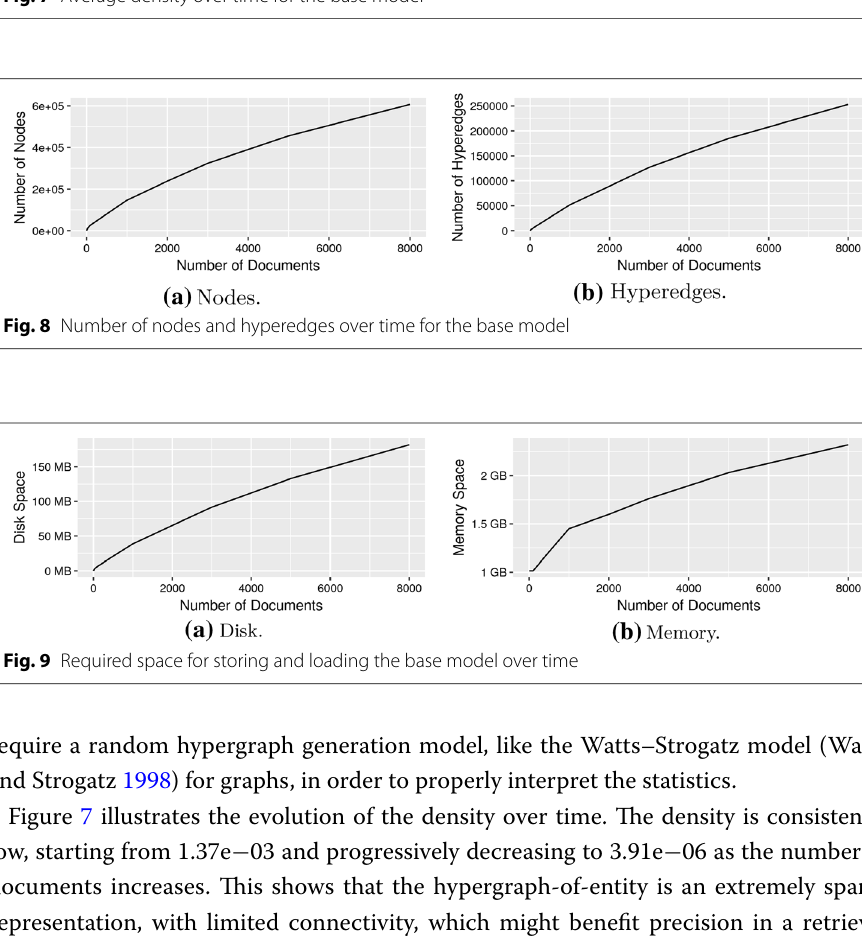
Fig. 7 Average density over time for the base model